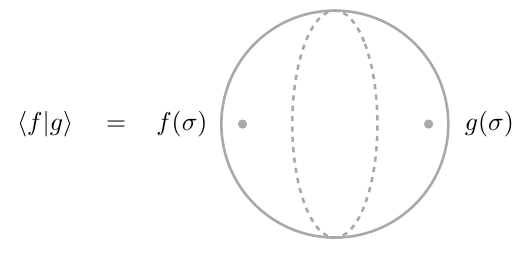
Figure 2. The inner product on the spin chain Hilbert space corresponds to two-point correlation functions in the A-twisted supersymmetric gauge theory on CP 1